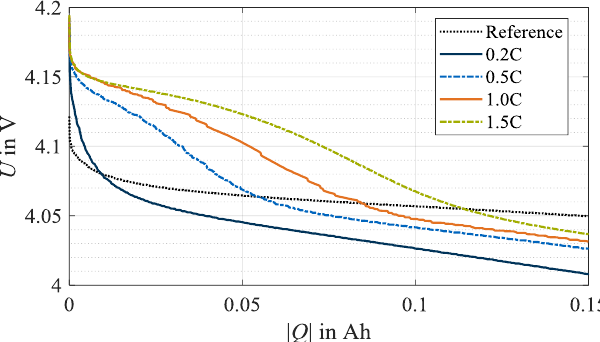
Figure 4. Beginning of stripping discharges at 0 °C after load cycle 1, whereby lithium plating is not detected at test points with a charge rate of 0.2C but with 0.5C, 1.0C and 1.5C. The reference data exemplifies the unaged condition of once cell specimen used in this test series at check-up test 0.